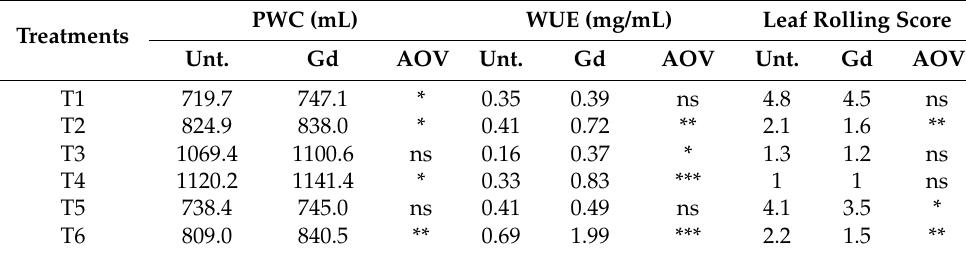
Table 2. The effects of water stress levels and N rates on plant water consumption (PWC), water use efficiency (WUE), and leaf rolling score of maize plants at the time of harvest. *, ** and *** indicate significance at p < 0.05, p < 0.01 and p < 0.001, respectively. PWC (mL) WUE (mg/mL) Leaf Rolling Score Treatments Unt.